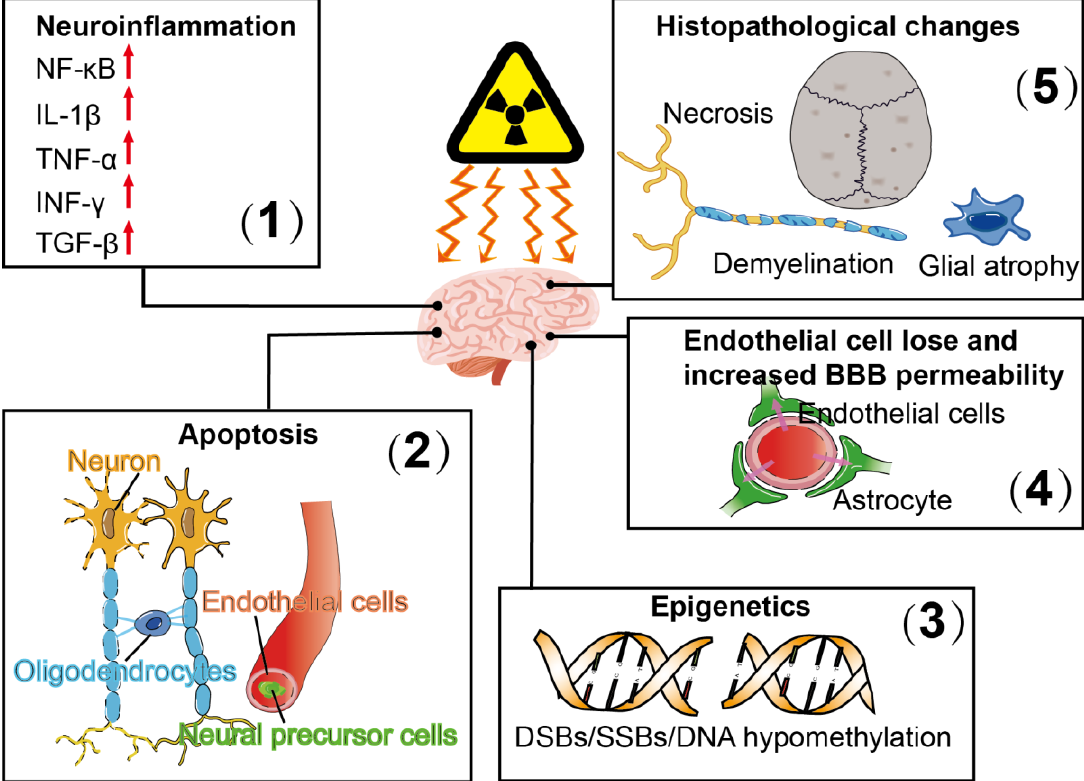
Figure 1. Pathophysiological responses of radiation-induced brain injury include (1) neuroinflammation, which is associated with increased expression of the transcription factor, nuclear factor kappa-light-chain-enhancer of activated B cells (NF-κB), as well as upregulated expression of interleukin-1 (IL-1)β, tumor necrosis factor α (TNF-α), interferon γ (INF-γ) and transforming growth factor β (TGF-β); (2) apoptosis of oligodendrocytes and neurons; (3) epigenetic alterations which are associated with DNA double-strand breaks (DSBs), DNA single-strand breaks (SSBs) and DNA hypomethylation; (4) endothelial cell loss and increased blood–brain barrier (BBB) permeability and (5) histopathological changes, including cell necrosis, glial atrophy and demyelination.